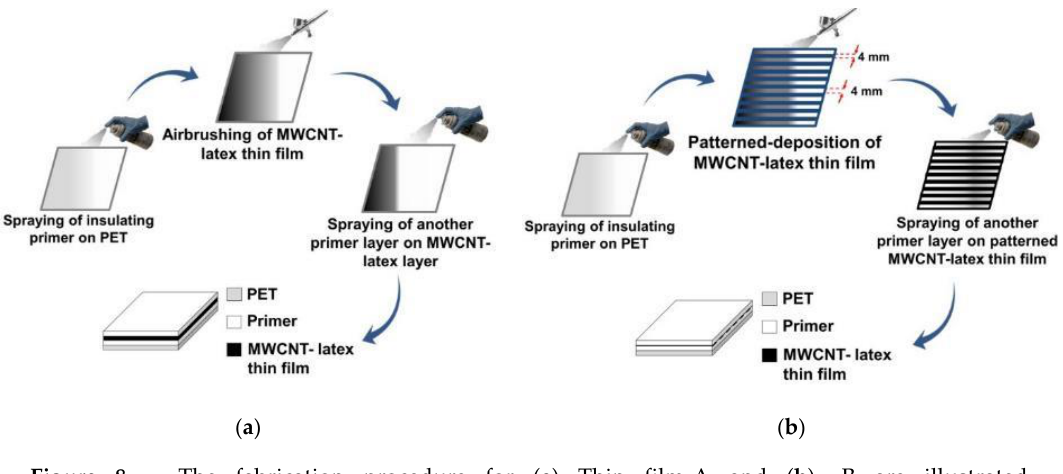
Figure 8. The fabrication procedure for ( a ) Thin film-A and ( b ) -B are illustrated. MWCNT — multi-walled carbon nanotube; PET — polyethylene terephthalate.